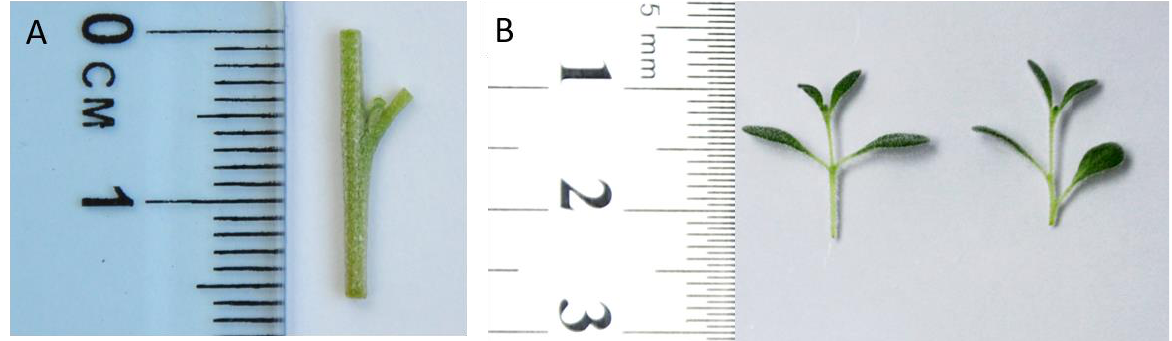
Figure 1. Propagation of initial explants from plant collections: ( A ) a uninodal segment used for the in vitro establishment of A. taltalensis ; ( B ) Initial explants with shoots used for multiplication.